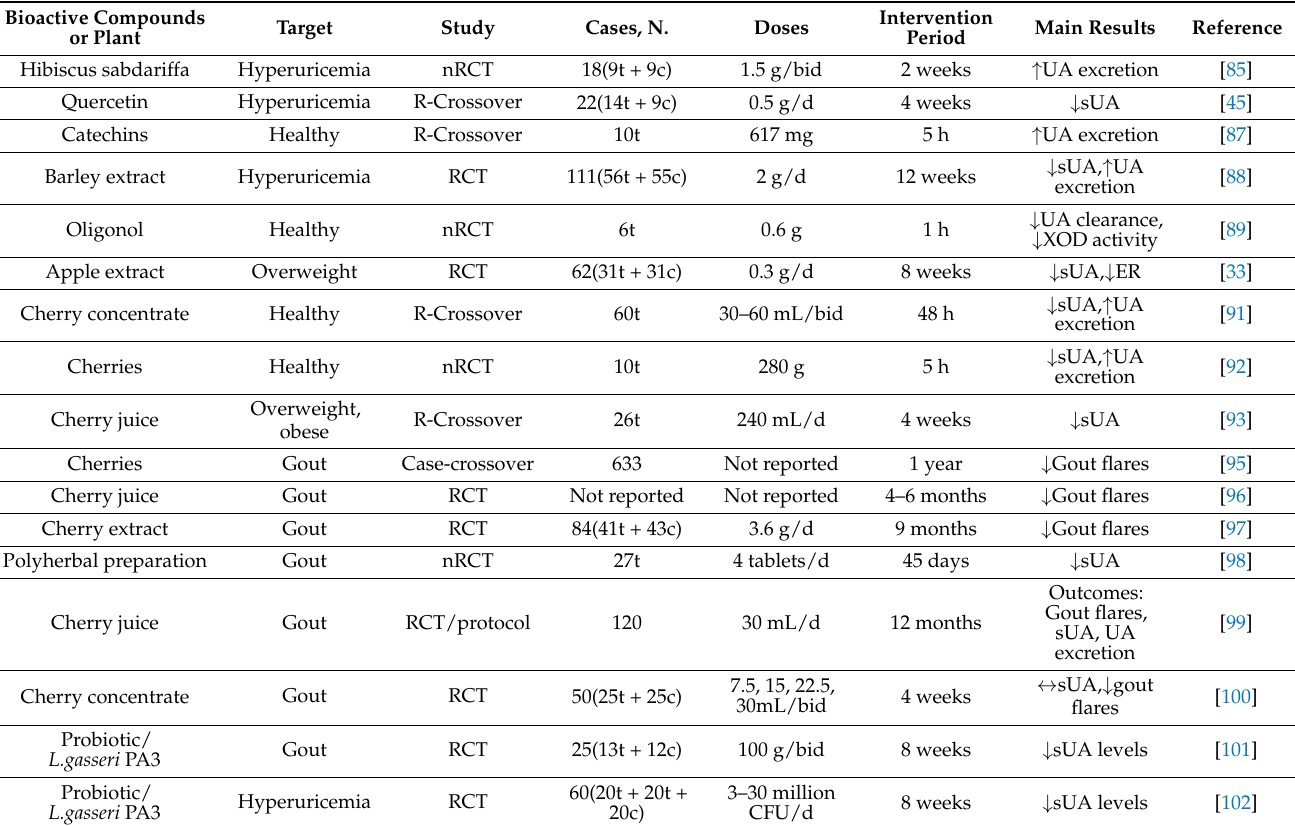
Table 3. Clinical studies carried out on bioactive compounds in gout and